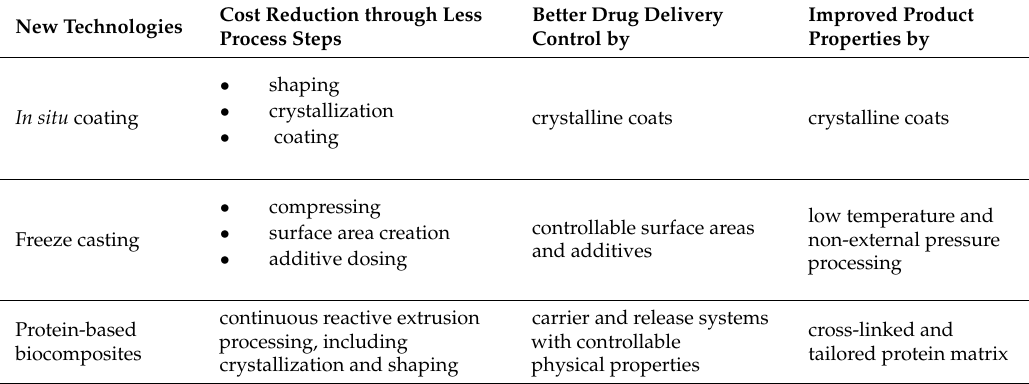
Table 1. Summary of positive points of aforementioned new technologies in the formulation of